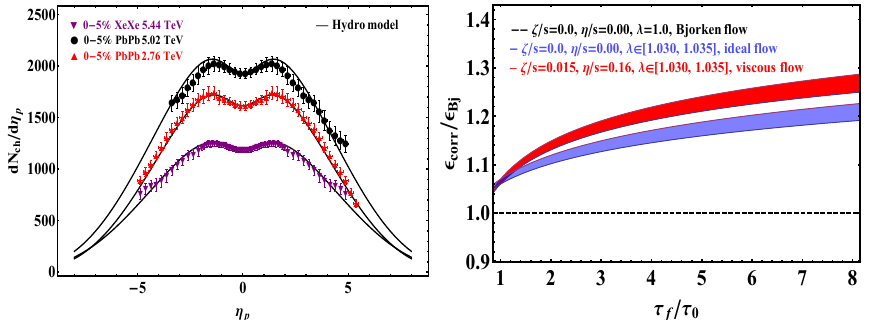
Figure 1. ( Left ): Pseudorapidity distribution from our model calculation (solid curves) compared to the LHC experimental data [16–18]. The black curves represent the pseudorapidity distribution √ √ √ s NN = 2.76 TeV Pb+Pb collisions, s NN = 5.02 TeV Pb+Pb collisions and s NN = 5.44 TeV for Xe+Xe collisions. ( Right ): the correction factor (cid:101) corr / (cid:101) Bj as a function of the ratio of freeze-out time and thermalization time ( τ f / τ 0 ) for different λ and shear viscosity ratio η / s , bulk viscosity ratio ζ / s . The black dashed line is the result of Bjorken model, while the red band is the result that include the viscosity effect enhancement (Equation(10)), and the blue band is the result from Equation (9). The band width comes from the uncertainty of λ ( − 1.030 ≤ λ ≤ 1.035). For the viscous fluid, the viscosity ratio is assumed to be constant [22,23] here and the statistical analysis of viscosity ratio is not discussed